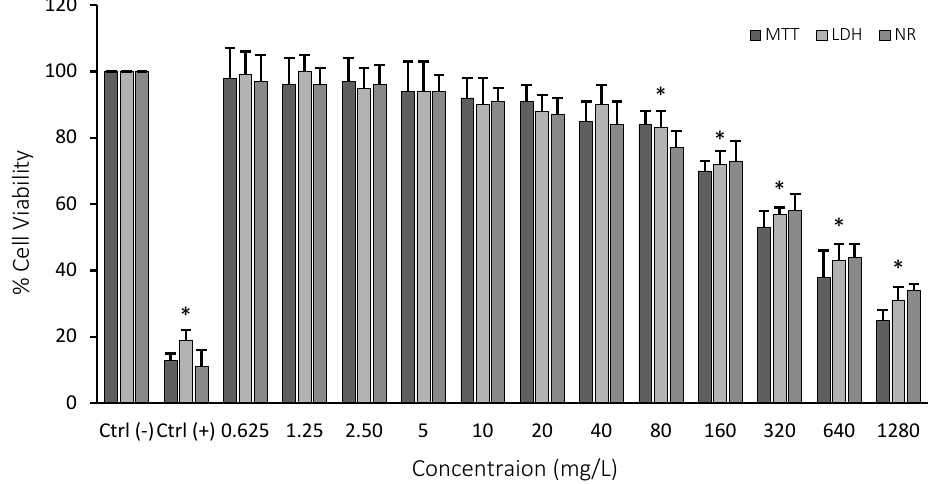
Figure 5. MTT, LDH, and NR assay results of cobalt boride (Co 2 B) nanoparticles on the human lung alveolar epithelial cell line. Ctrl ( − ): negative control (only cell culture), Ctrl (+): positive control (hydrogen peroxide (H 2 O 2 )). Symbol (*) represents statistically significant decrease in cell viability at 80 mg/L concentration, p < 0.05 (Microsoft Excel 2010, ANOVA: Single Factor and Regression Analysis were used to calculate the values).